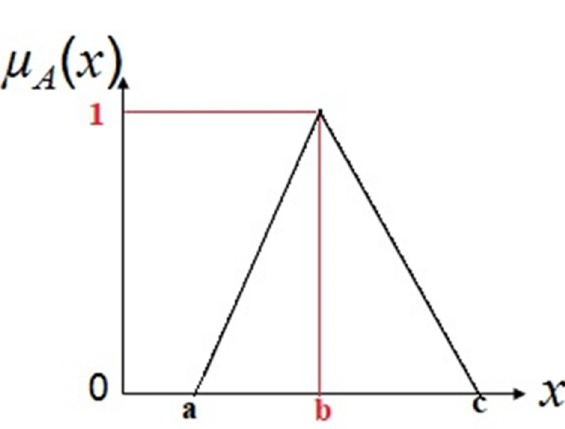
Figure 8. Triangular fuzzy membership